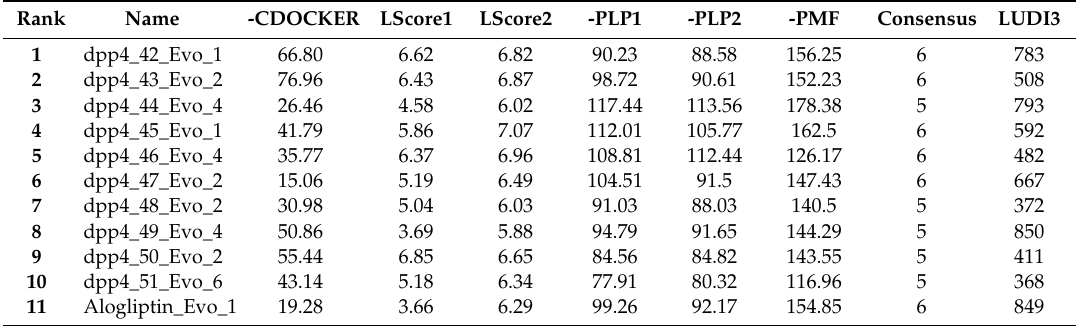
Table 4. Molecular docking results for the derivatives generated by de novo Evolution protocol from top 10 DPP-IV